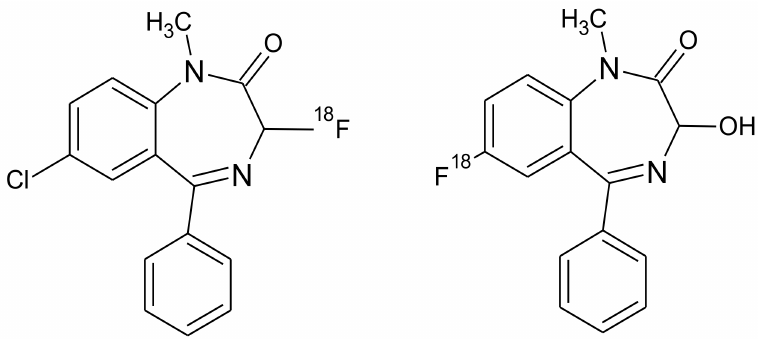
Figure 6. Possible radiochemical impurities of [ 18 F]F-FETEM